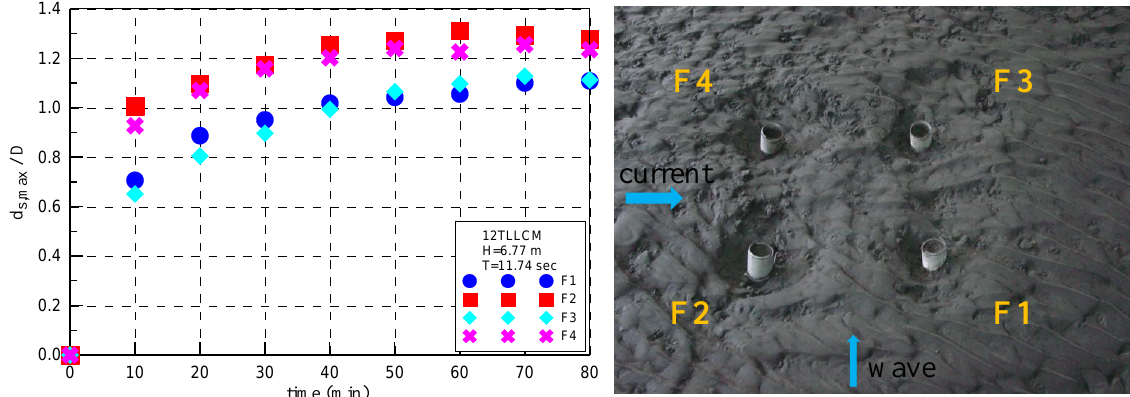
Figure 3. The evolution of the scour depth around the four piles of the jacket-type foundation for the case, 12TLLCM, (12, 12-m water depth; T, 100-year return period typhoon wave; LL, lower low water level; C, current; M, mobile